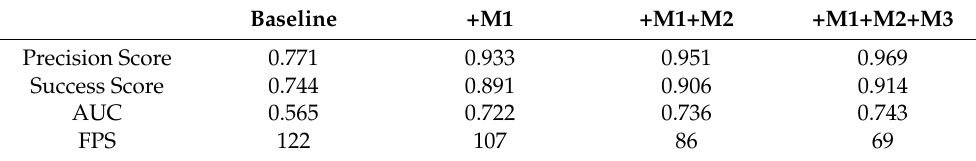
Table 8. Results of ablation experiment.